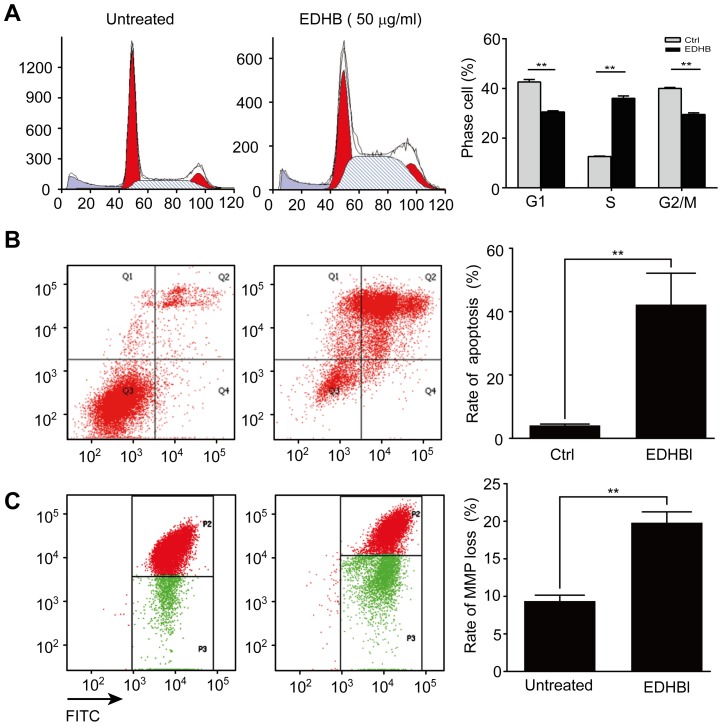
EDHB induced changes in cellular morphology.KYSE170 cells were treated with EDHB for 48 h and 72 h. (A) The cell cycle analysis was determined at the 48 h time point; the cell cycle profiles are shown. The histogram of statistical analysis on the right is the percentage of S phase cells. (B) Apoptosis was analyzed at the 72 h time point by Annexin-V-PI staining using flow cytometry. The histogram of statistical analysis on the right is the percentage of cell death. (C) The mitochondrial membrane permeabilization was measured at the 48 h time point using flow cytometry. The histogram of statistical analysis on the right is the rate of mitochondrial membrane permeabilization loss. Ctrl, EDHB untreated control; **, P<0.05.